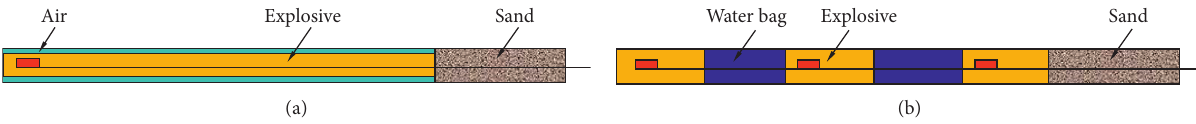
Figure 2: Two types of charge patterns of blasting. (a) Normal blasting. (b) Water-decked